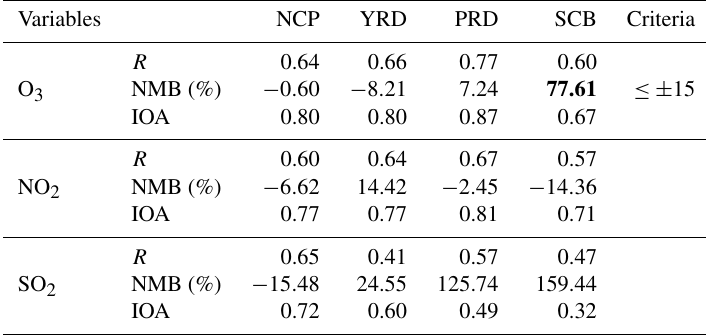
Table 4. Statistical metrics for O 3 and NO 2 concentrations. Criteria for O 3 are from the EPA (2005, 2007). The value that does not meet the criteria is in bold. Variables